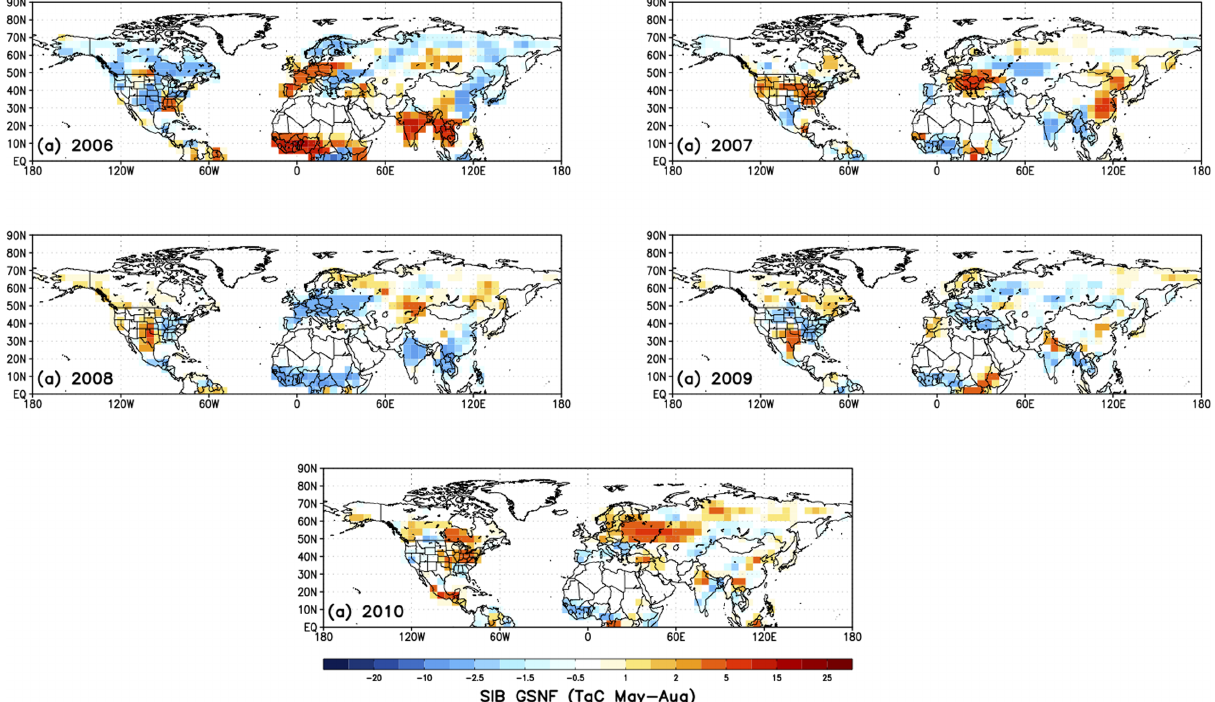
Fig. 4. Spatial distribution of annual anomalies in growing season net flux (average SiB NEE from May–August), representing the difference of annual mean GSNF from the five-year climatological average for (a) 2006, (b) 2007, (c) 2008, (d) 2009, and (e) 2010. Interannual vari- ability is clearly evident throughout North America, Europe, and Boreal Asia, with anomalies representing 10% or less of the climatological average.